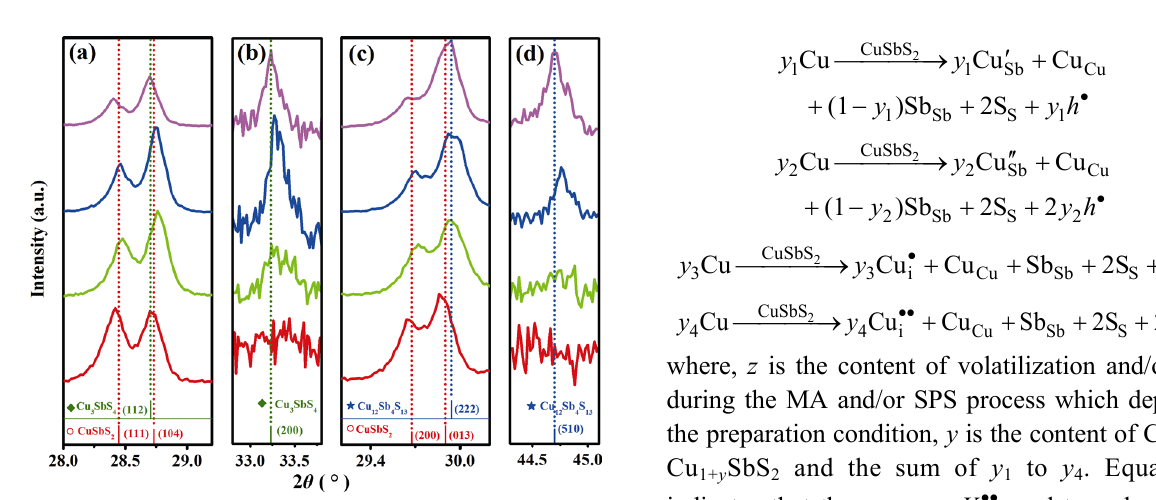
Fig. 2 XRD patterns of the bulk samples with the mole ratio of (1– x )CuSbS 2 – x Cu 1.8 S ( x = 0, 0.1, 0.2, 0.3) at 2 θ range of (a) 28°–29°, (b) 32.8°–33.8°, (c) 29.2°–30.2°, and (d) 44.3°–45.1°.